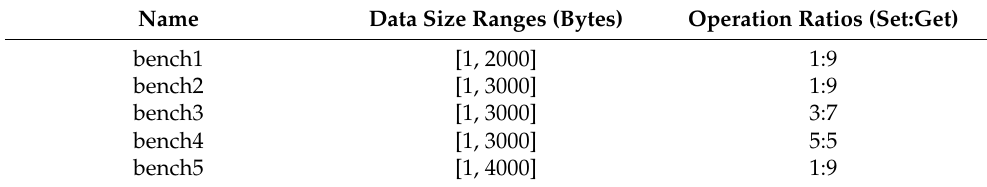
Table 3. Workloads configurations.